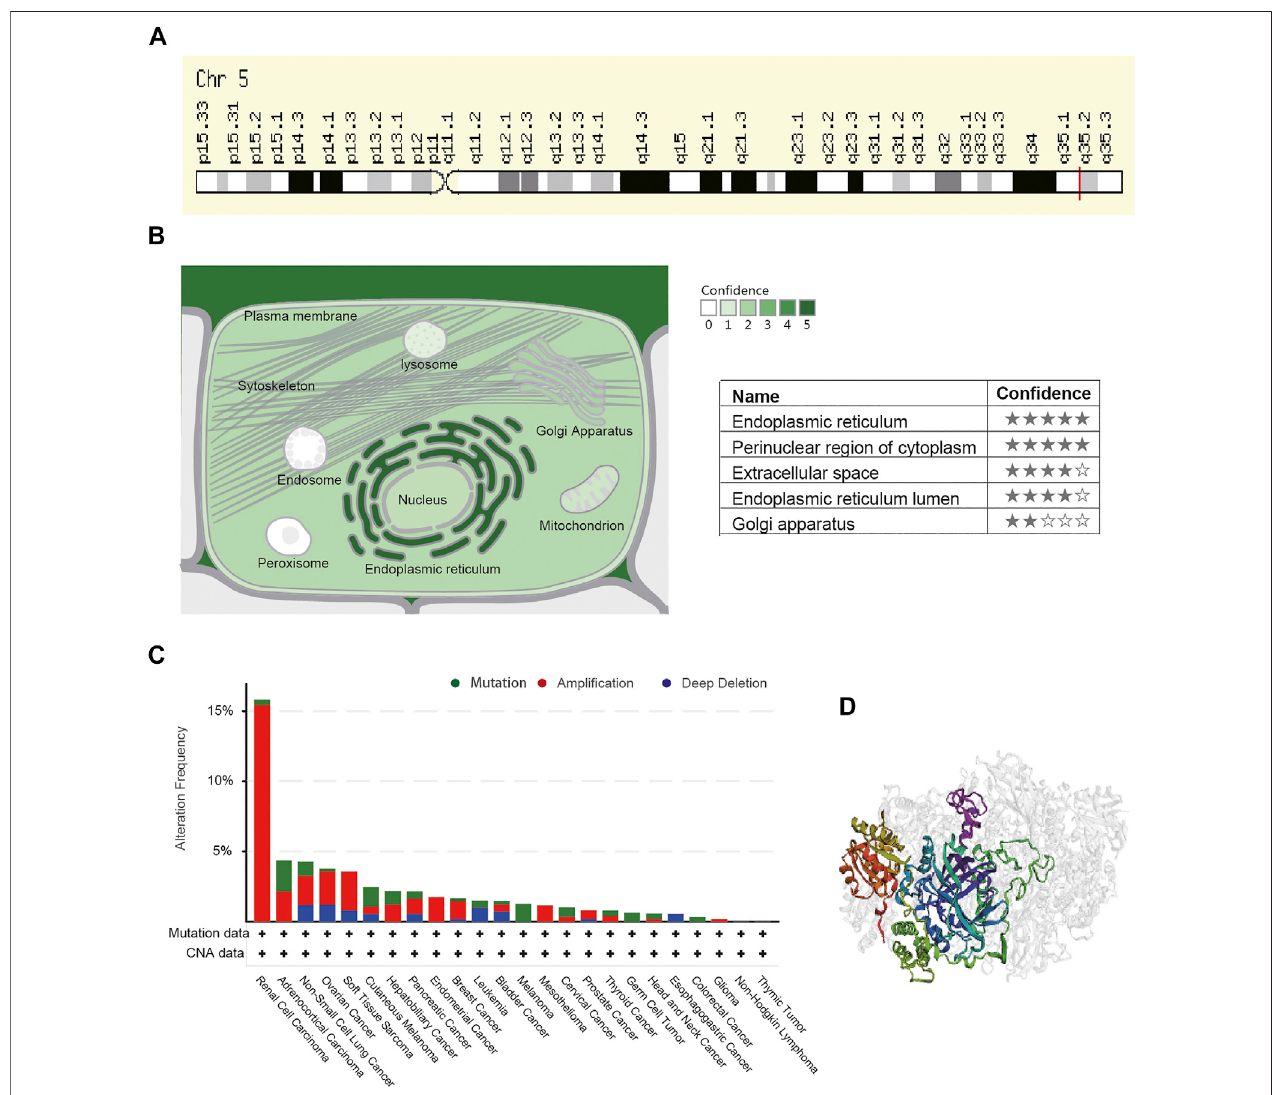
FIGURE 10 | Basic biology of STC2 and genetic alteration analysis. (A) Genomic location of STC2 gene in the GeneCards website. (B) Subcellular location of STC2 by COMPARTMENTS. (C) Mutation type and frequency of STC2. (D) Three-dimensional (3D) structures of STC2.